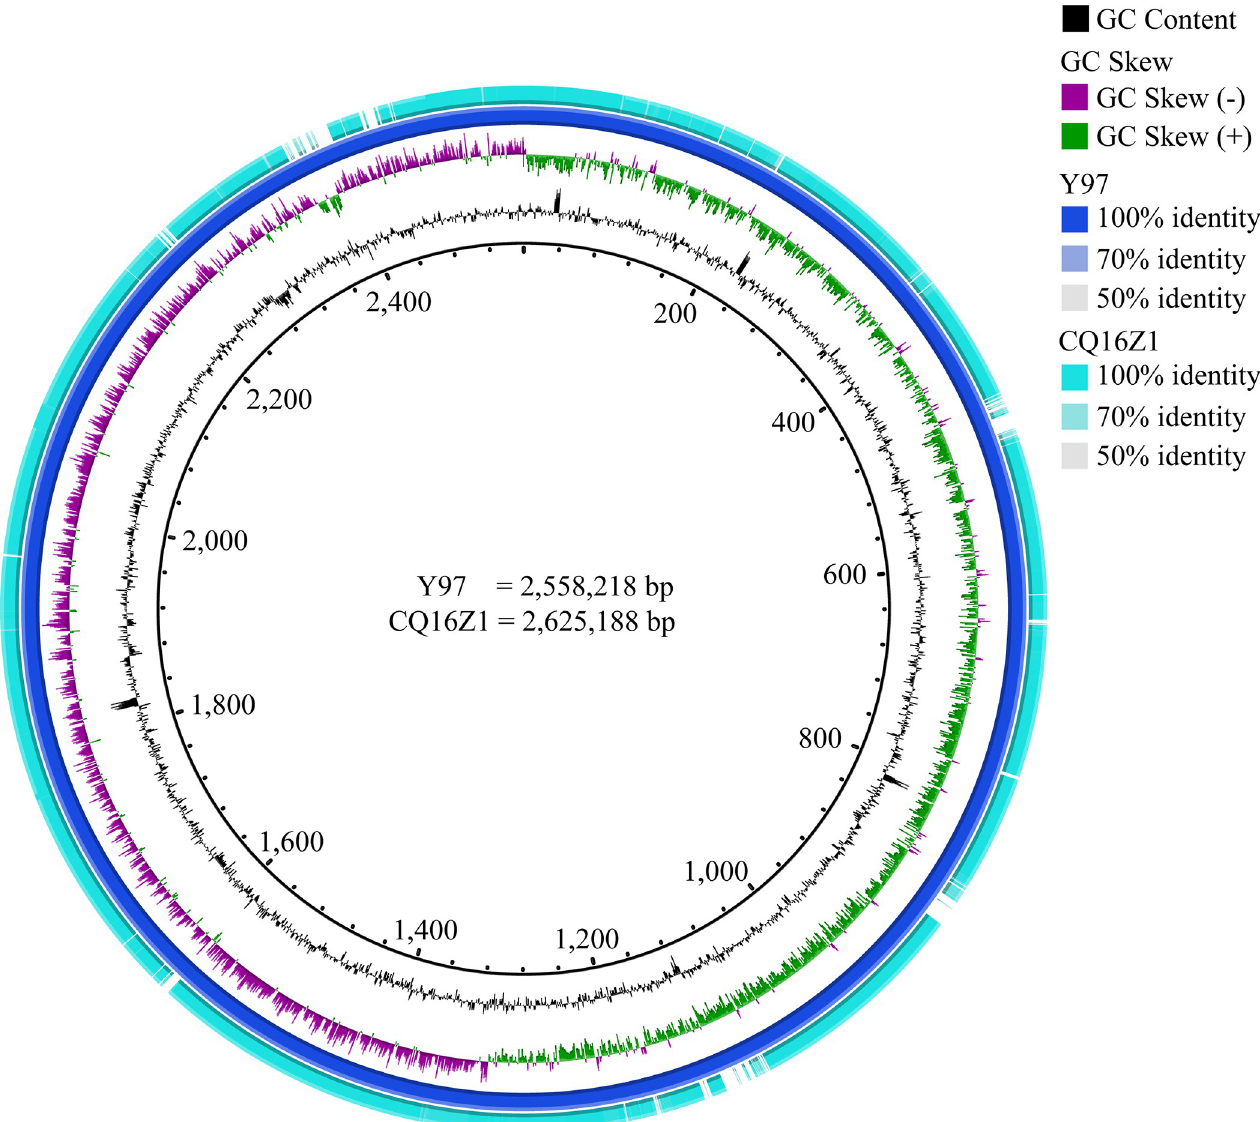
Fig 3. Chromosomes comparison circle of CQ16Z1 and Y97. 1.From the outside to the inside, the first circle represented the chromosome of CQ16Z1, and the second circle represented the chromosome of Y97. 3. The minimum identity was 50%.